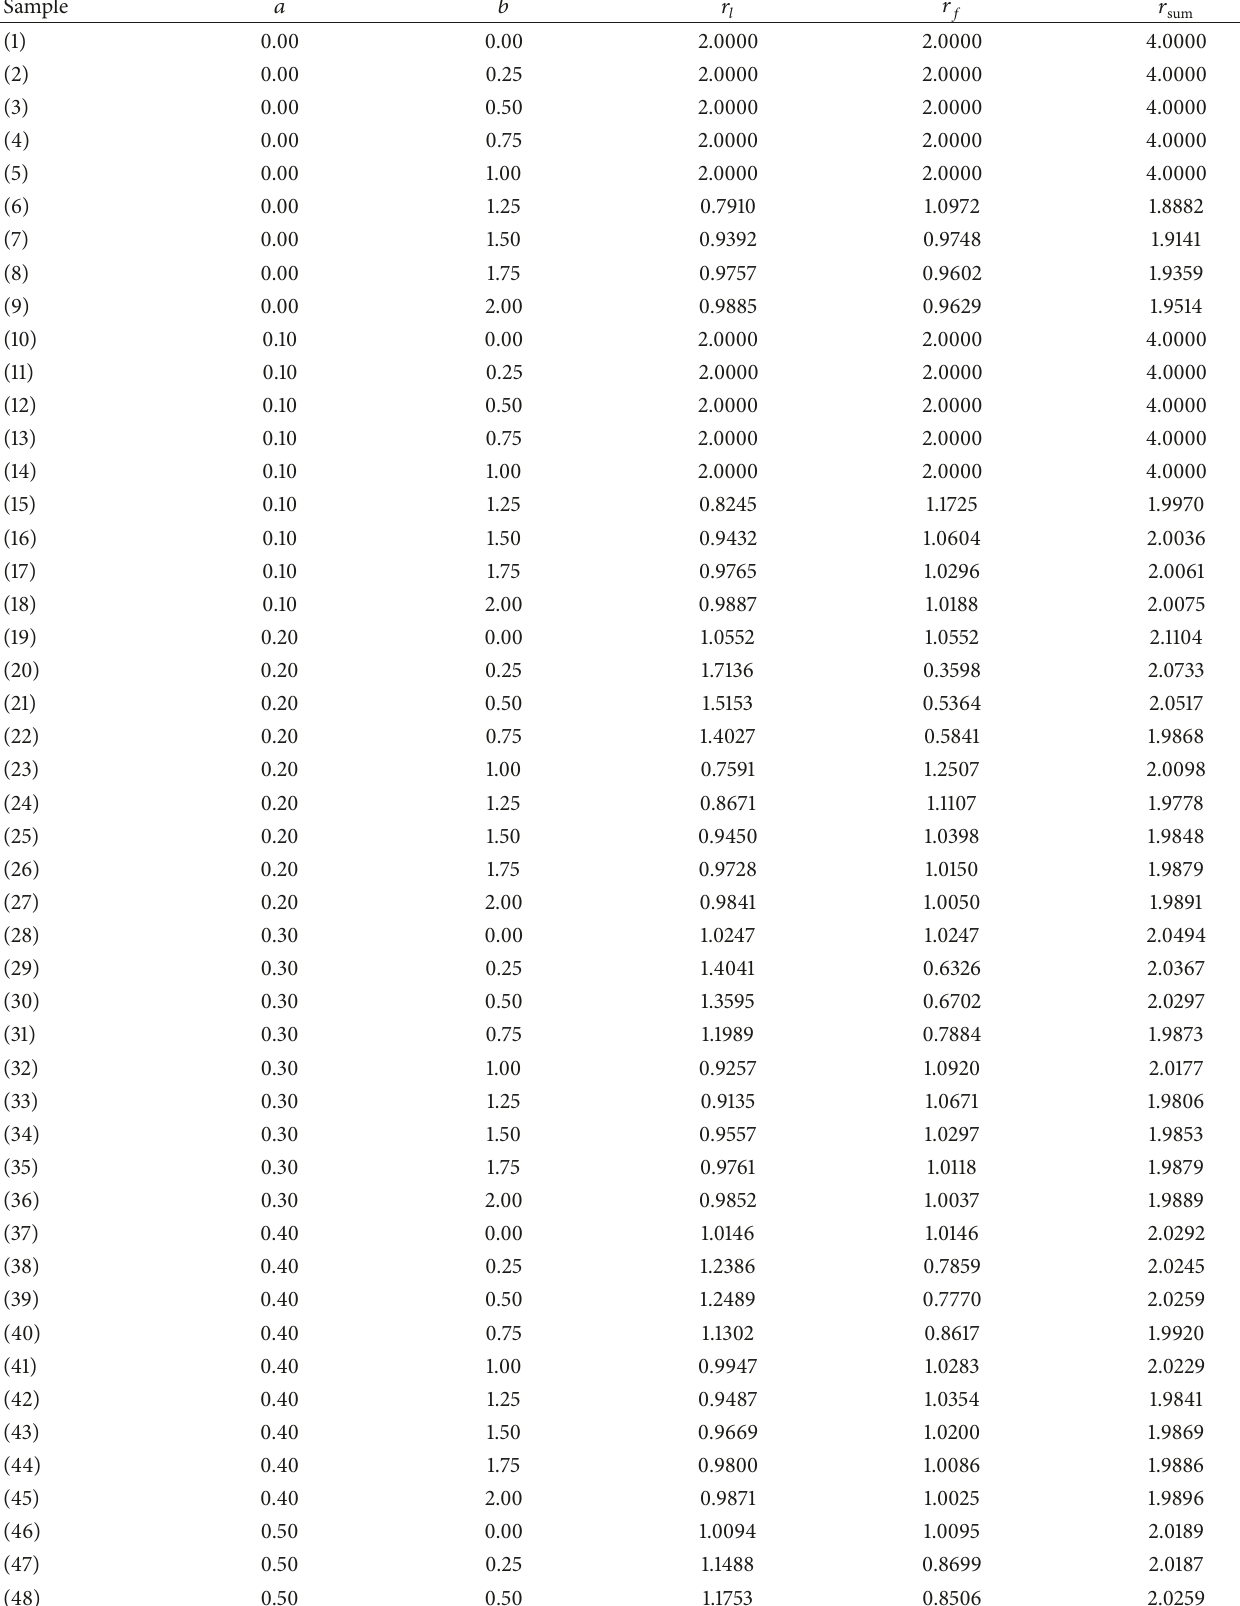
Table 3: CFD data for the training